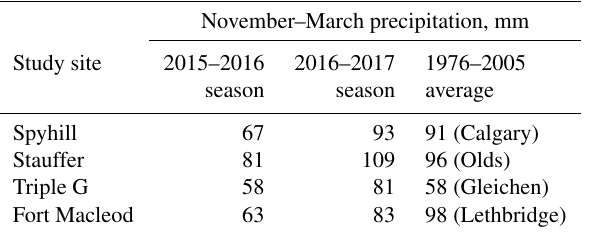
Table 2. Precipitation at the study sites and long-term averages for weather stations indicated in brackets (Mekis and Vincent,